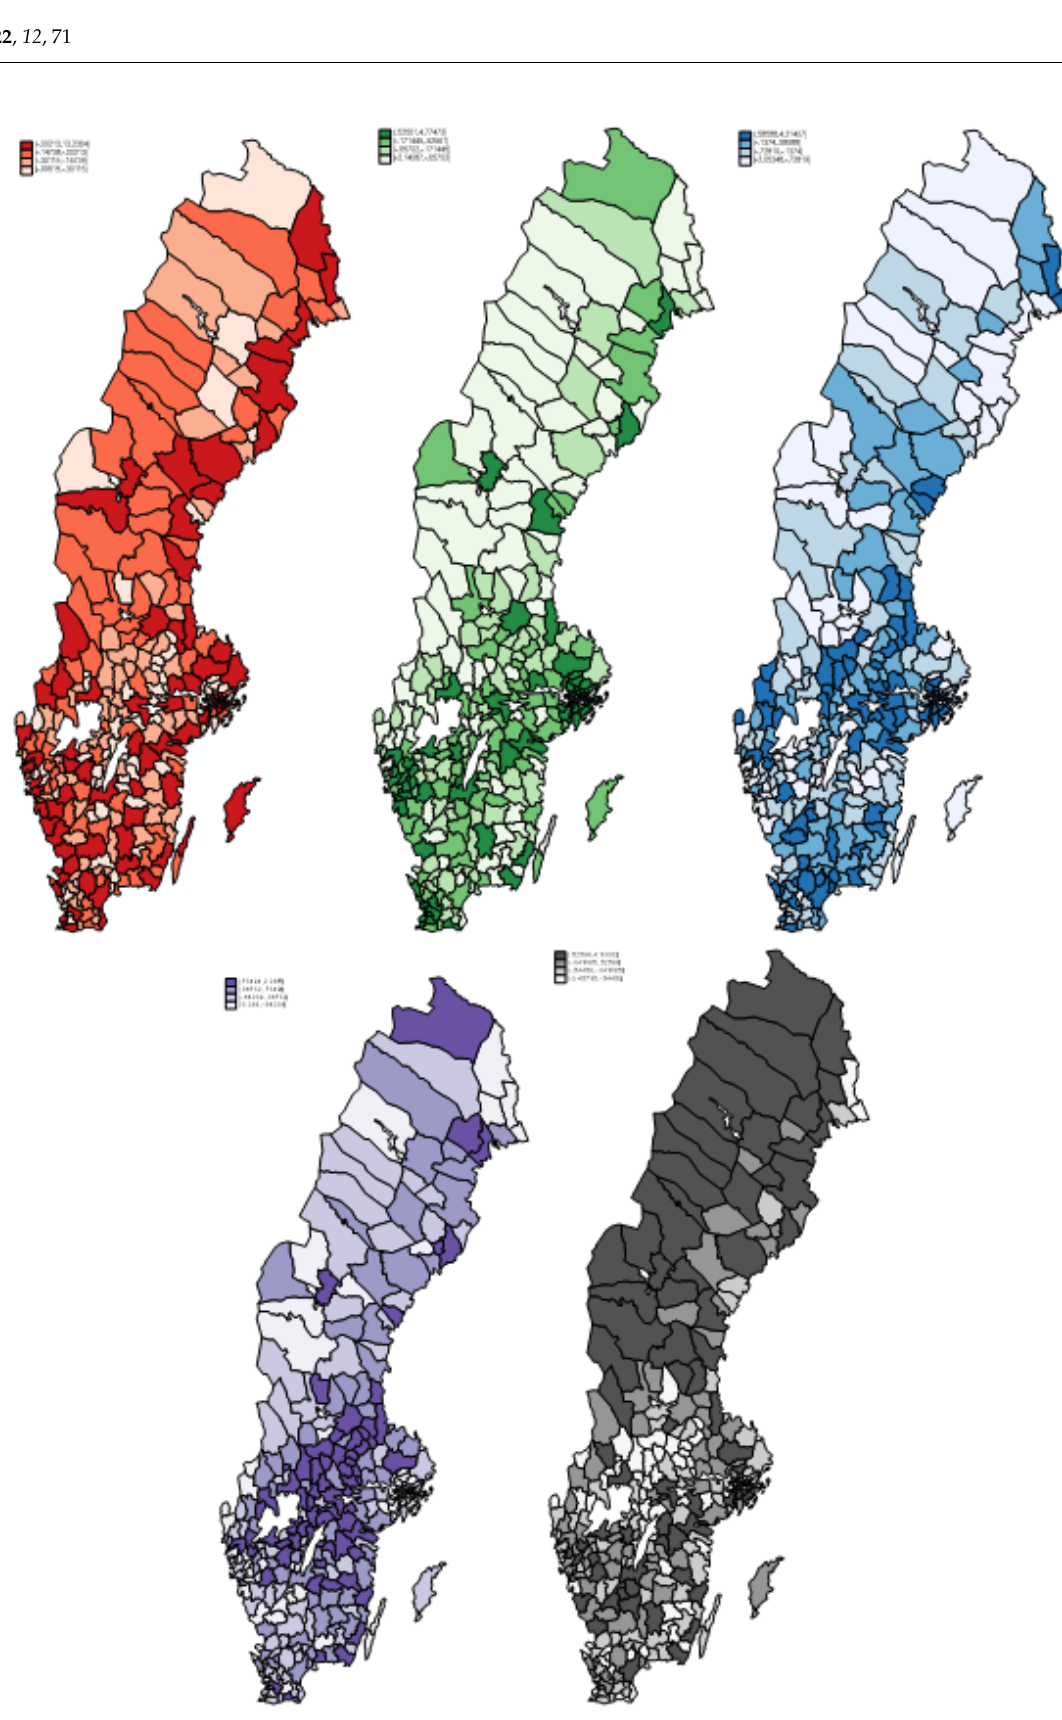
Figure 5. Housing components (h1 – h5) distribution in space.